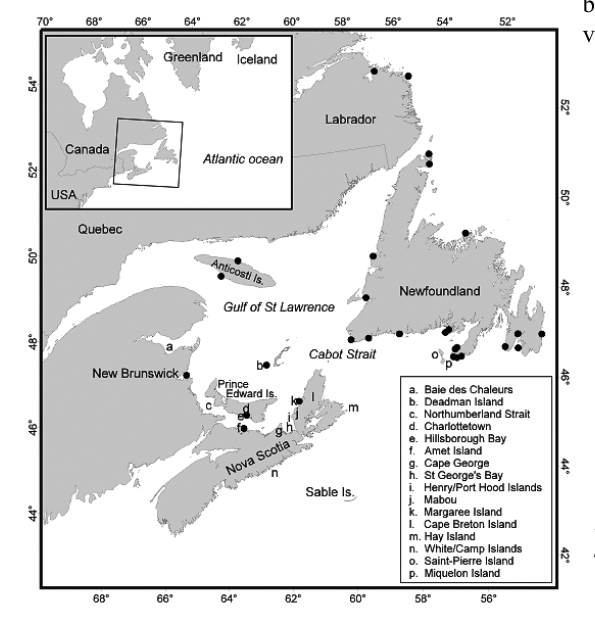
Fig. 1. Map showing region where grey seals were collected. The dots represent locations where animals were